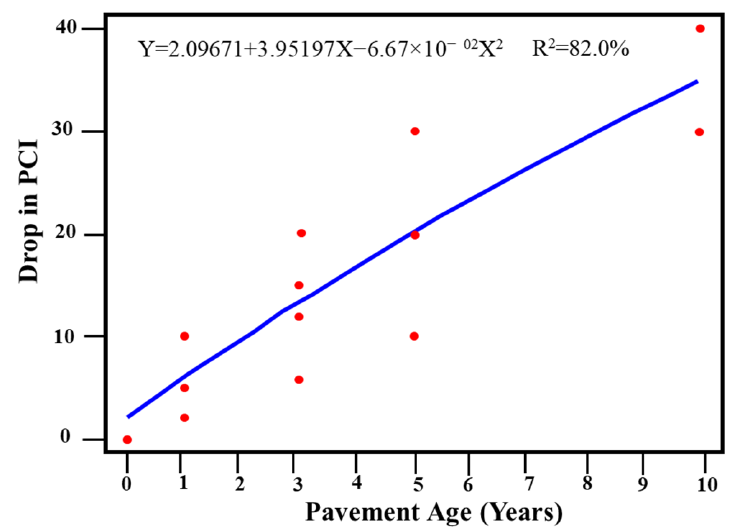
Figure 5. Effect of the no maintenance strategy on the deterioration of PCI for low traffic.